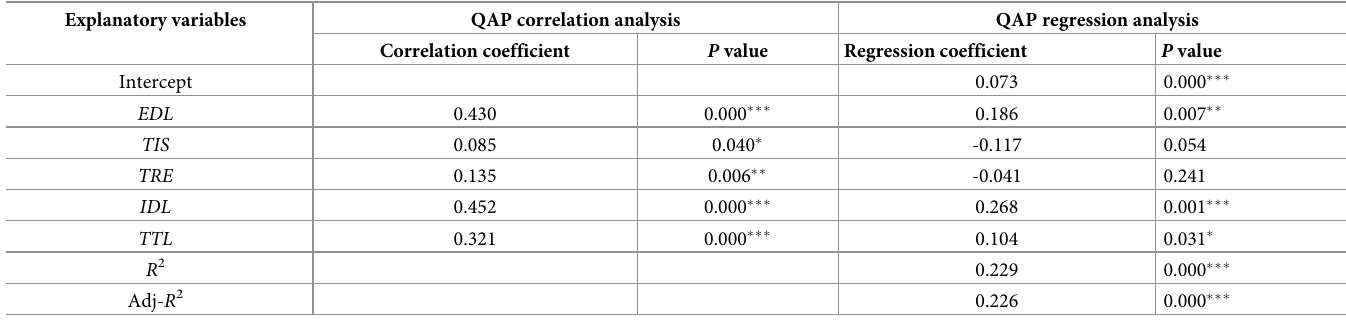
Table 5. QAP correlation analysis and regression analysis